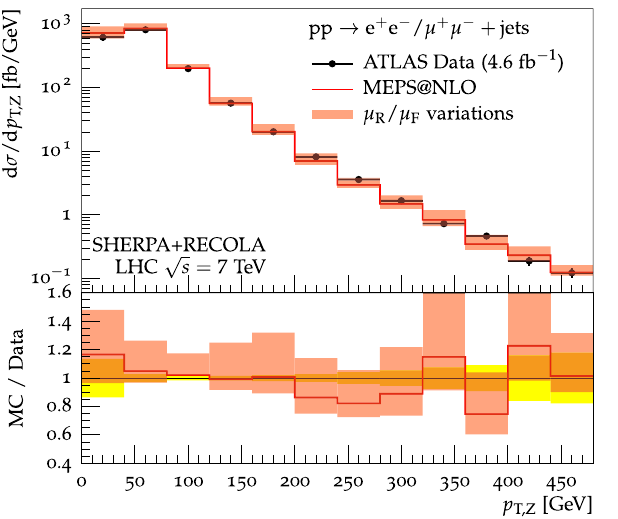
√ s = 7TeV CMS data [72]. The theoretical- ity in comparison to uncertainty band is obtained through 7-point scale variations of μ R and √ μ s = 7TeV LHC data from F . The yellow bands in the lower panels indicate the measurements combined statistical and systematic uncertainty